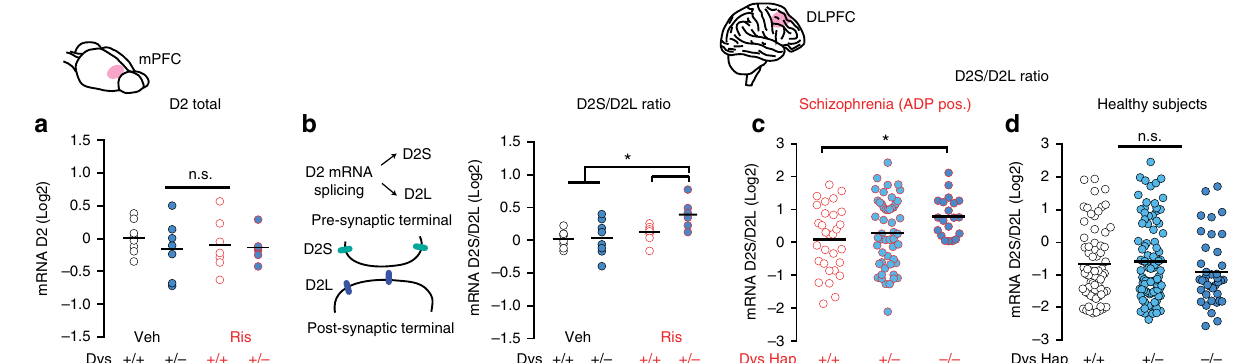
Fig. 5 Antipsychotics generate an imbalance in cortical D2 receptor isoforms only in subjects with reduced dysbindin-1 expression. a Neither dysbindin-1 reduction (Dys + / − dark blue circles, Dys + / + white circles) nor risperidone treatment (Ris in red) affected total D2 receptor expression in the mPFC ( n = 6 – 7 each group). b Increased D2S/D2L ratio in the mPFC of Dys + / − after chronic treatment with Ris ( n = 6 – 7 each group; two-way ANOVA, treatment, F = 8.67, p < 0.05; genotype, F = 4.25, p < 0.05). c The D2S/D2L ratio in the DLPFC was increased in schizophrenia patients with reduced (1, 25) (1, 25) dysbindin-1 expression (Dys Hap − / − , dark blue circles) who tested positive in antipsychotic screening (ADP pos.) compared to Dys Hap + / + patients (white circles; one-way ANOVA, F (2, 98) = 3.26, p < 0.05; n = 101). We did not observe any difference in D2S/D2L ratio from postmortem human brains of the DLPFC of patients with schizophrenia in which antipsychotics where not detected (one-way ANOVA, F (2, 55) = 0.90, p = 0.41; n = 58). d The D2S/D2L ratio in the DLPFC from postmortem human brains of healthy subjects was similar across genotypes ( n = 199; one-way ANOVA, F (2, 194) = 1.06, p = 0.34). Error bars represent S.E.M. * p < bar). Error bars represent S.E.M. * p < 0.05, ** p < 0.005